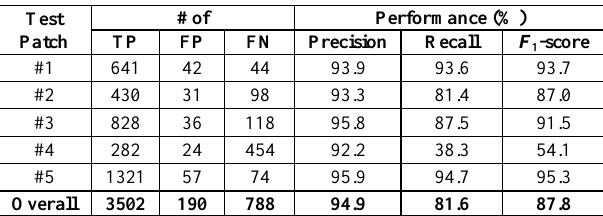
Table 2. Results of the proposed approach Test Patch